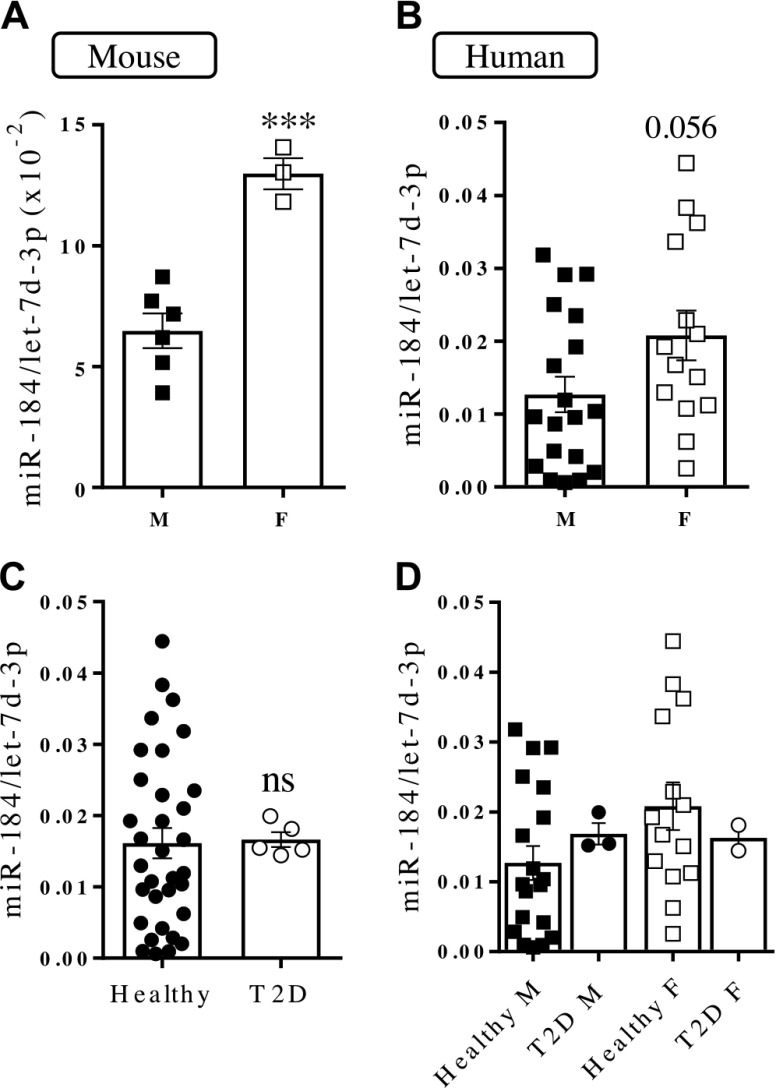
miR-184 expression is sex dependent. miRNA expression was assessed by RT-qPCR in isolated islets from male (M) and female (F) control mice (A), human islets from male and female donors (B), human islets from healthy donors and donors with T2D (C), and human islets from healthy male and female donors and male and female donors with T2D (D). Each dot represents islets from a single mouse (A) or human donor (B–D). Data are expressed as relative to the endogenous control let-7d-3p. ns, not significant. ***P < 0.001 (Student’s t test).